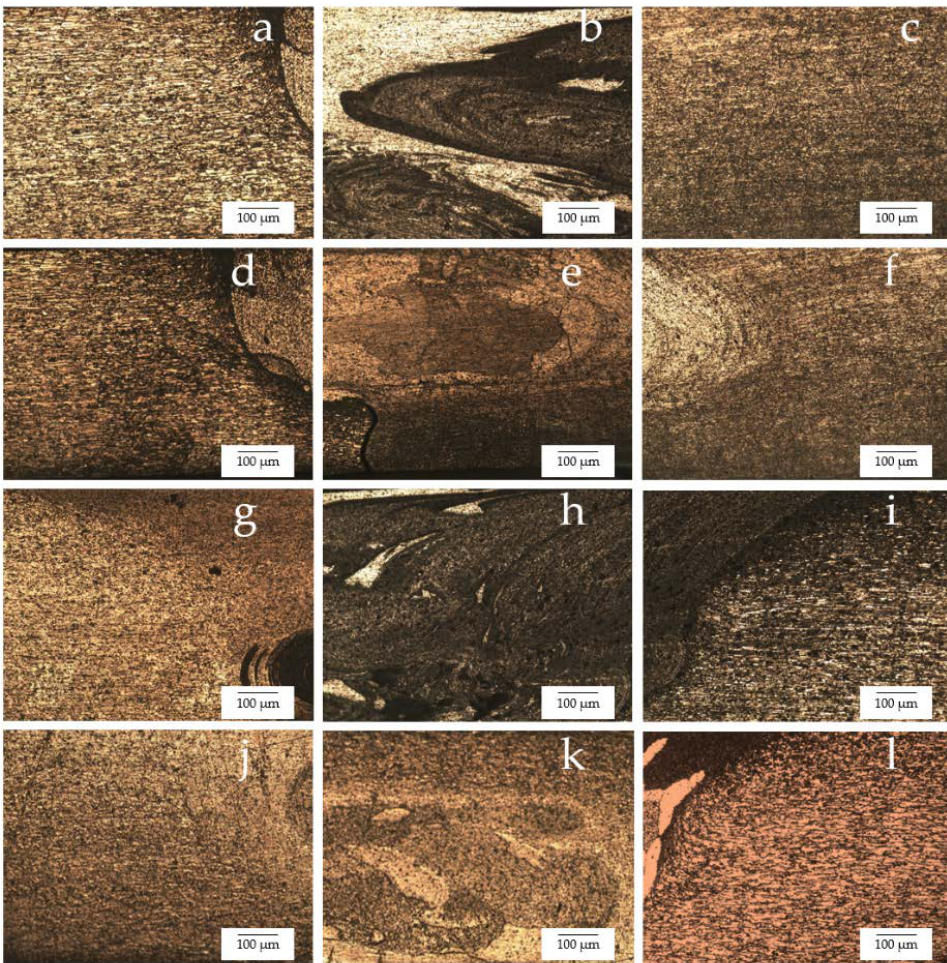
Figure 23. Microstructure of the workpieces: ( a ) TMAZ-AS of FSW; ( b ) SZ of FSW; ( c ) TMAZ-RS of FSW; ( d ) TMAZ-AS of FSW-PWHT; ( e ) SZ of FSW-PWHT; ( f ) TMAZ-RS of FSW-PWHT; ( g ) TMAZ-AS of FSW-DR; ( h ) SZ of FSW-DR; ( i ) TMAZ-RS of FSW-DR; ( j ) TMAZ-AS of FSW-PWHT-DR; ( k ) SZ of FSW-PWHT-DR; ( l ) TMAZ-RS of FSW-PWHT-DR.